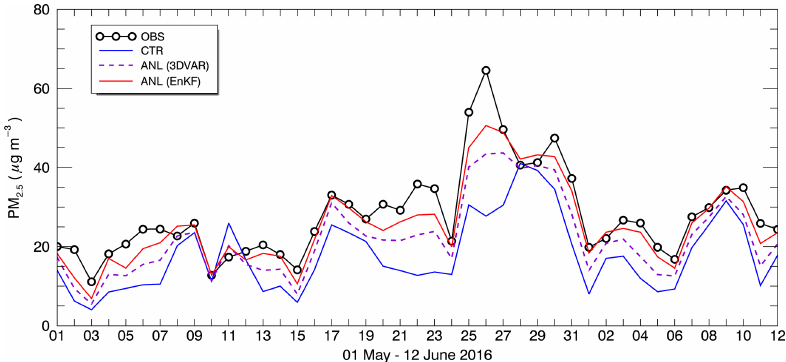
Figure 3. Daily variations of surface PM 2 . 5 for the DA_ic experiment. Observations (OBS) are represented by a black solid line with open circles. Model results for the control (CTR) run without DA, the reanalysis (ANL) run with 3D-Var, and reanalysis ANL with EnKF are plotted with a blue solid line, purple dashed line, and red solid line, respectively. Values were prepared from daily averages at all the observation sites in South Korea (D2).